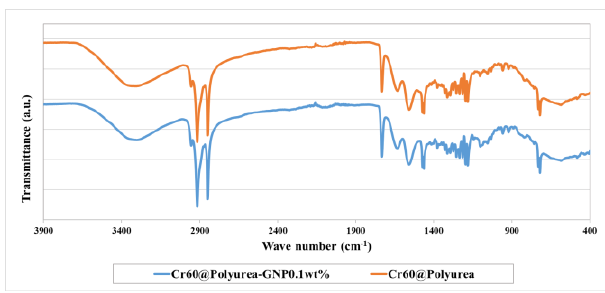
Figure 3. FTIR spectra of Cr60@polyurea-0.1%GNP and Cr60@Polyurea